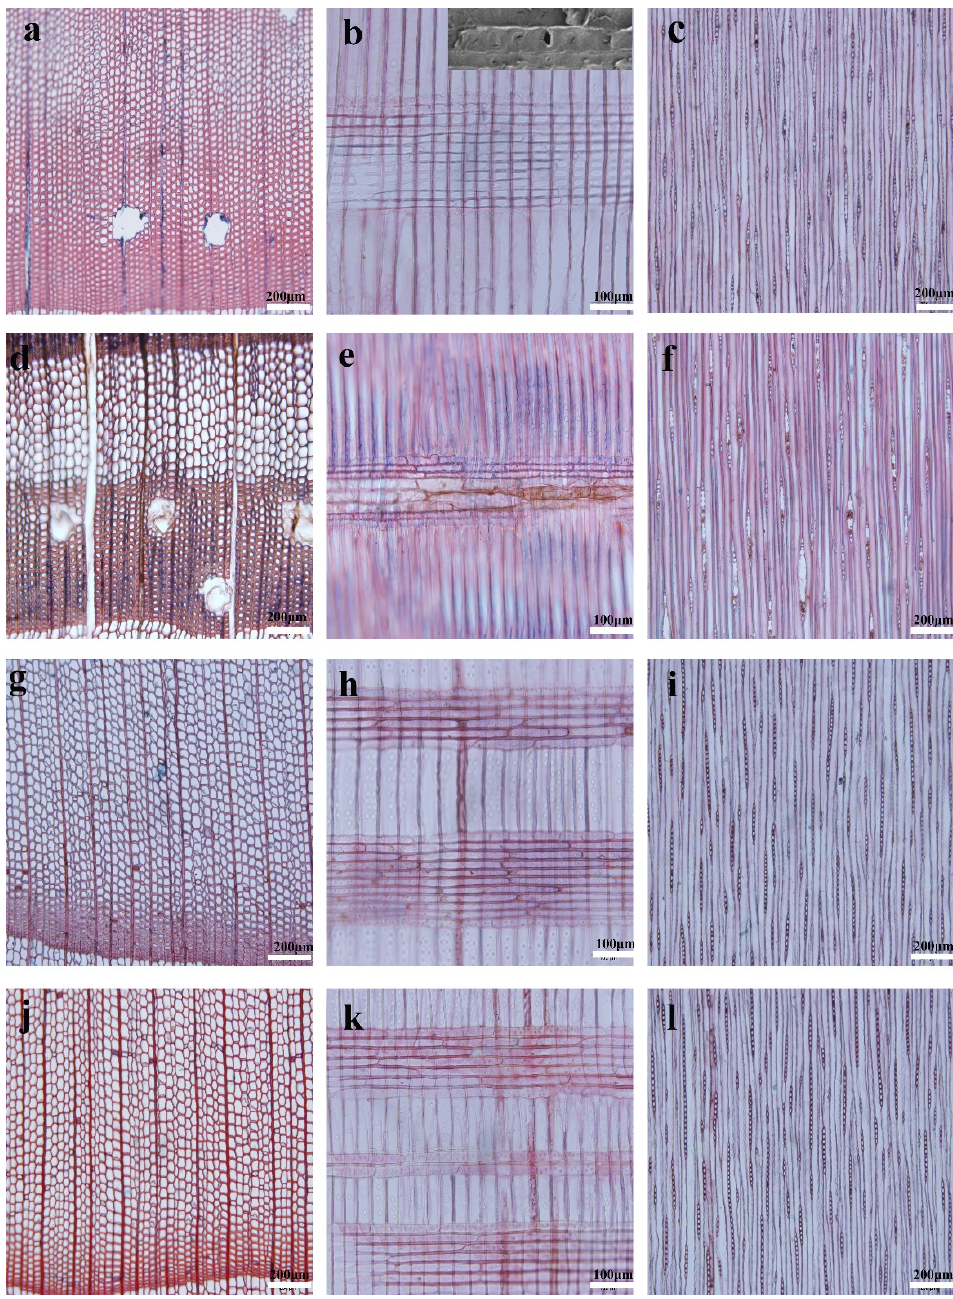
Figure 1. Optical micrographs of the transverse, radial and tangential sections from Masson pine: juvenile wood ( a – c ) and mature wood ( d – f ); Chinese fir: juvenile wood ( g – i ) and mature wood ( j – l ). A SEM graph for the schematic measurement of ray parenchyma cell length is inserted in the top right corner of Figure 1b.